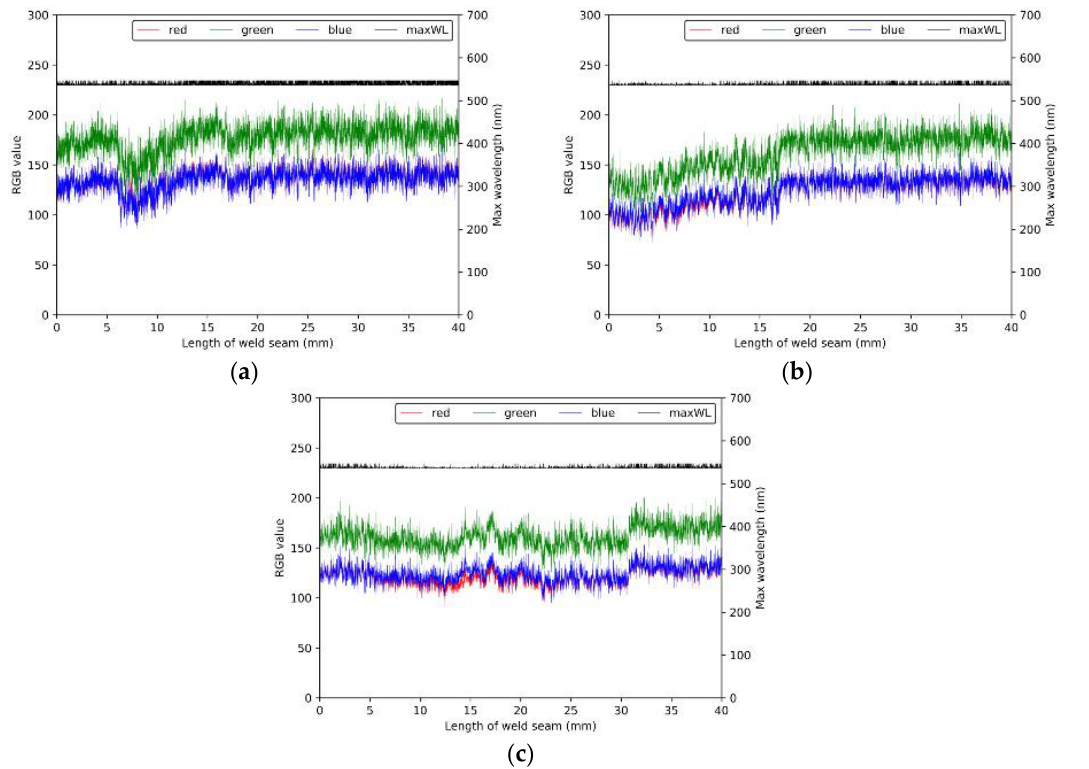
Figure 9. RGB values and maximum wavelength, at 0.8 mm gap and 3000 W laser power: welding speed of ( a ) 1.5 m/min; ( b ) 2.0 m/min; ( c ) 2.5 m/min.